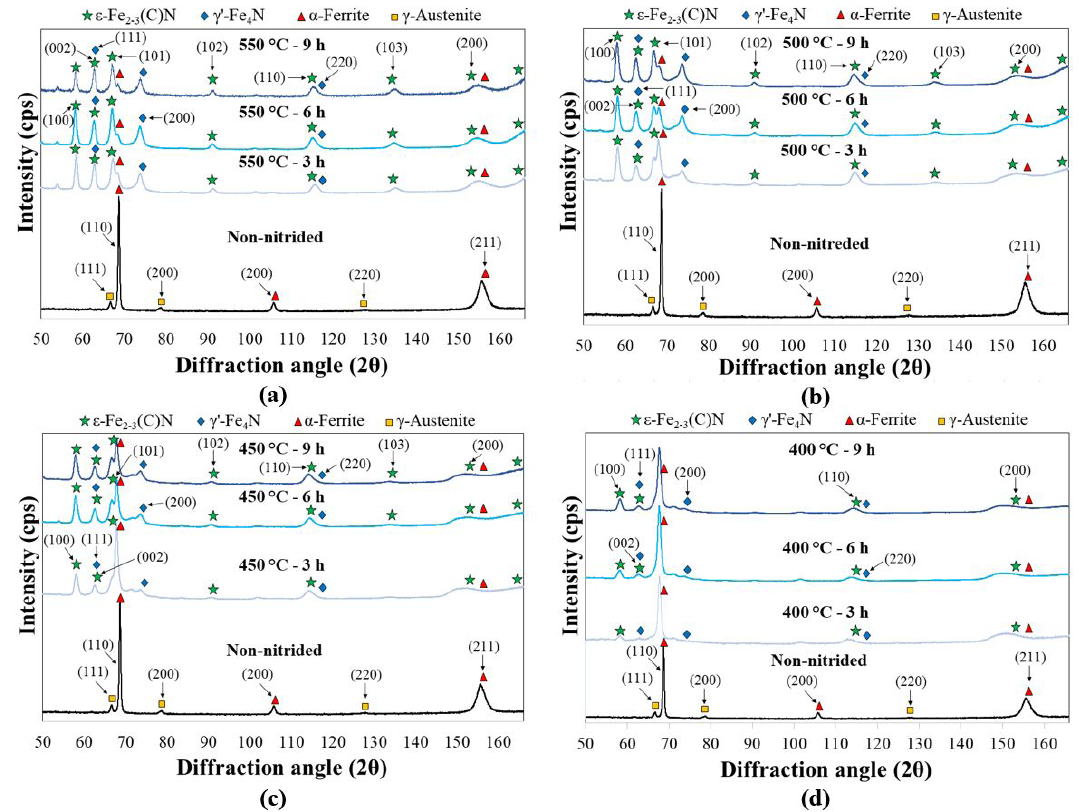
Fig. 5. X-ray diffractograms of non-nitrided sample and plasma nitrided samples at (a) 550 °C, (b) 500 °C, (c) 450 °C and (d) 400